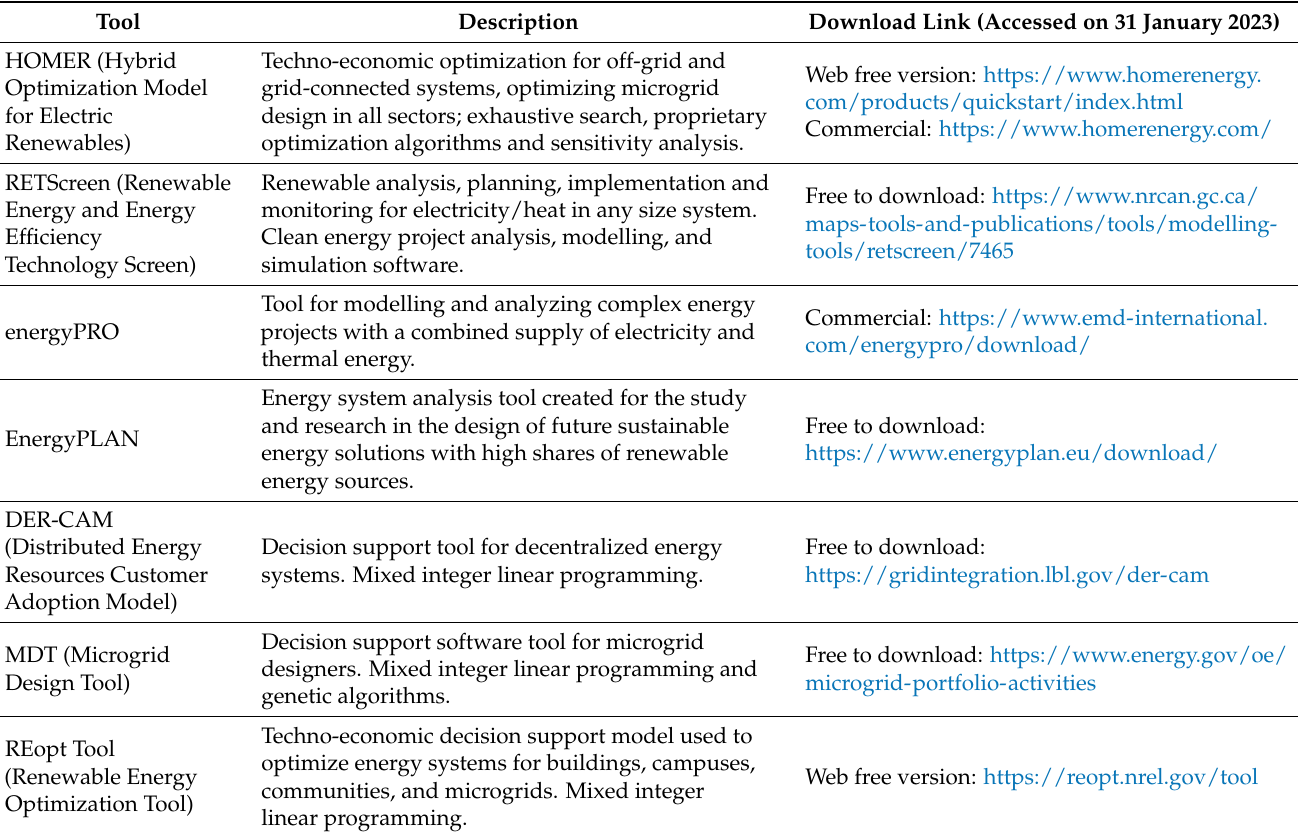
Table 1. Presentation of optimization computer tools for